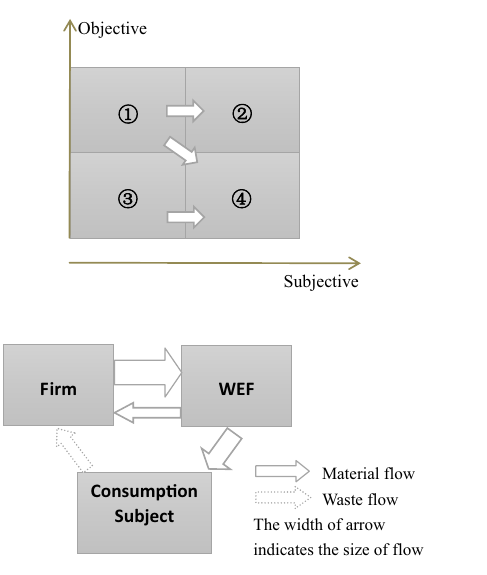
Figure 2. Firm agents ’ supply